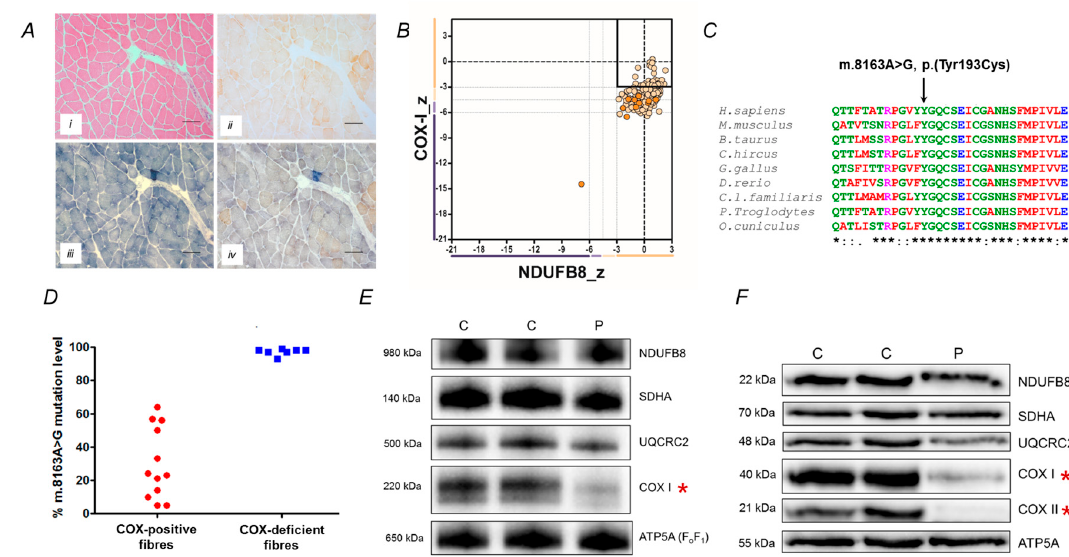
Figure 3. Histopathological, biochemical and molecular characterisation of a novel. MT-CO2 variant. ( A ) Histological and histochemical analyses of the patient’s skeletal muscle biopsy showing (i) hematoxylin and eosin (H&E) staining, (ii) COX, (iii) SDH and (iv) sequential COX-SDH histochemistry; scale bar, 100 µ m. ( B ) Quadruple immunofluorescence analysis of NDUFB8 (complex I) and COXI (complex IV) showing a marked loss of COXI expression. Each dot represents the measurement from an individual muscle fibre, color co-ordinated according to its mitochondrial mass (low = blue, normal = beige, high = orange, very high = red). Gray dashed lines represent standard deviation (SD) limits for a classification of the fibres. Lines next to x- and y-axis represent the levels of NDUFB8 and COXI: beige = normal ( > − 3), light beige = intermediate positive ( − 3 to − 4.5), light purple = intermediate negative ( − 4.5 to − 6), purple = deficient ( < − 6). Bold dashed lines represent the mean expression level of normal fibres. ( C ) Multiple sequence alignment highlighting the evolutionary conservation of p.(Tyr193) which is mutated in the m.8163A > G patient. ( D ) Single fibre PCR analysis clearly shows marked segregation of the m.8163A > G variant with a biochemical defect in individual COX-deficient muscle fibres. ( E ) Muscle protein from age-matched controls (C) and patient (P) muscle (15 µ g) were analysed by SDS PAGE (12%) and immunoblotting (see Methods), revealing a decrease in steady-state levels of both COX1 and COX2 (highlighted by asterisk) ( F ) Mitochondrial proteins (4.5 µ g) isolated from patient muscle (P) and controls (C) and analysed by one dimensional BN-PAGE (4 to 16% gradient) using subunit-specific oxidative phosphorylation system (OXPHOS) antibodies show decreased assembly of complex IV (asterisked). Complex II (SDHA) was used as a loading control in both (panels E and F